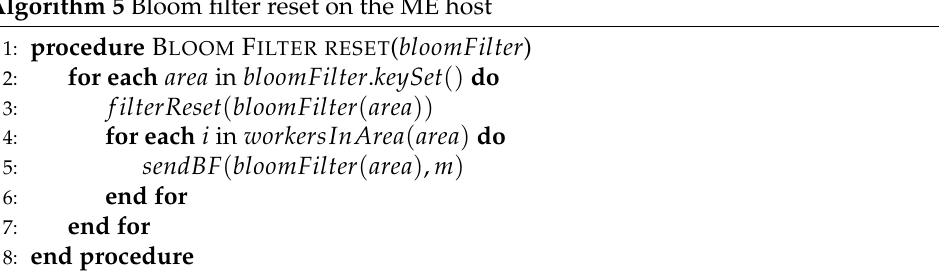
Algorithm 5 Bloom filter reset on the ME